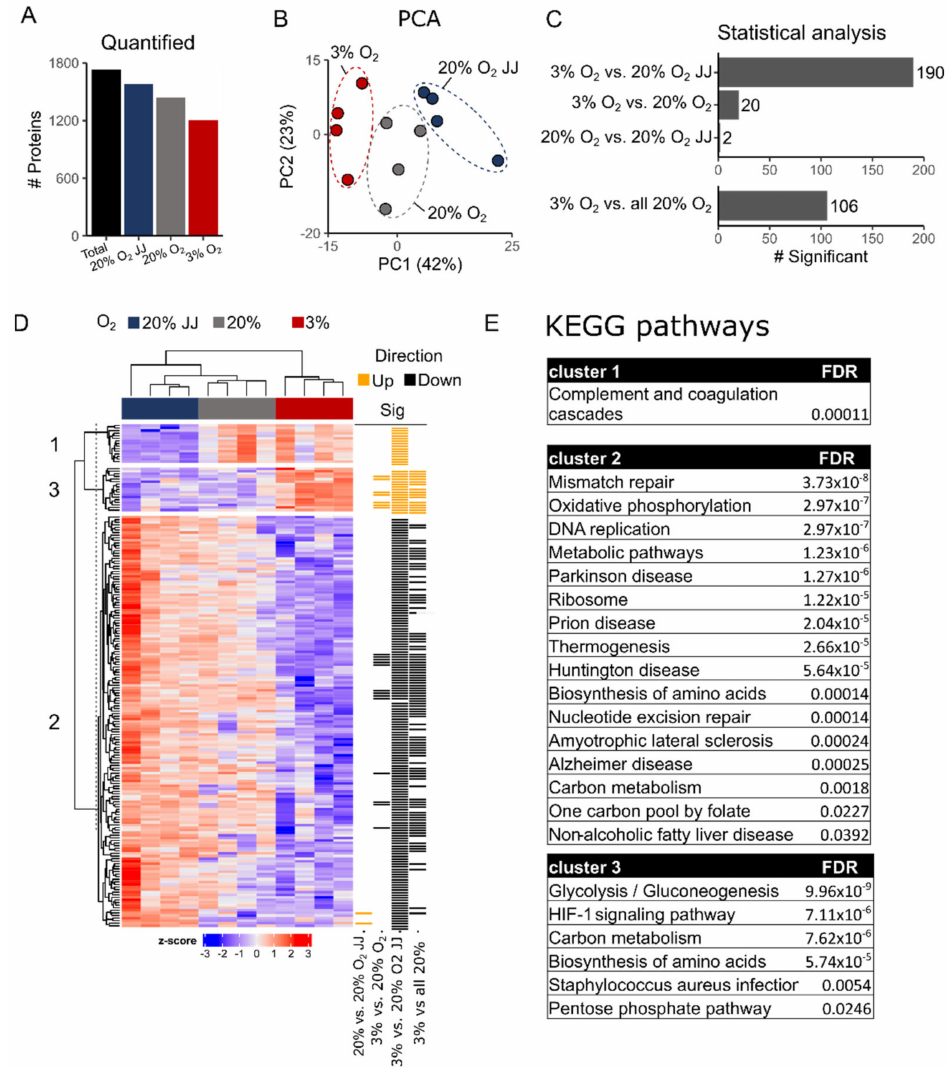
Figure 6. Proteomics analysis. ( A ) Amount of quantified proteins per experimental group and in the total proteomics dataset. ( B ) Principal component analysis (PCA) of 20% O 2 JJ, 20% O 2 and 3% O